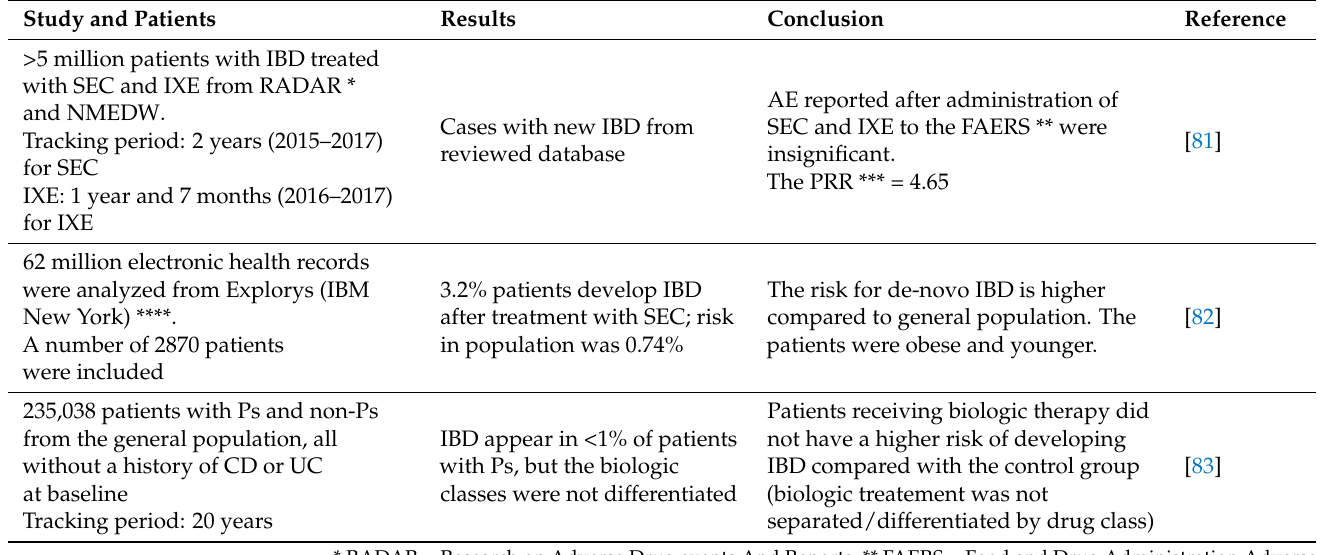
Table 3. Pharmacovigilance